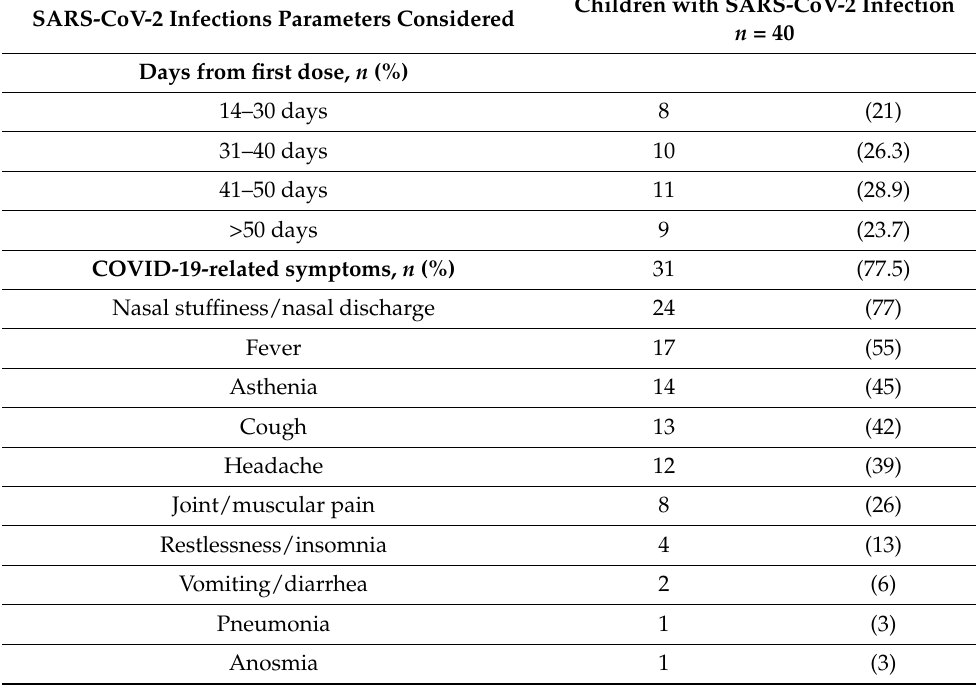
Table 5. SARS-CoV-2 infection in children after two doses of immunization. SARS-CoV-2 Infections Parameters